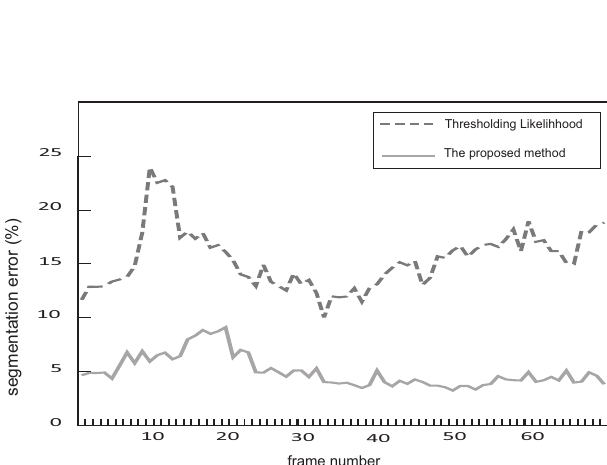
Figure 4. The segmentation and mixing results of a walking person. Left: the input images; Middle: segmentation results using the proposed al- gorithm. Right: mixing the segmentation results with another back- ground.